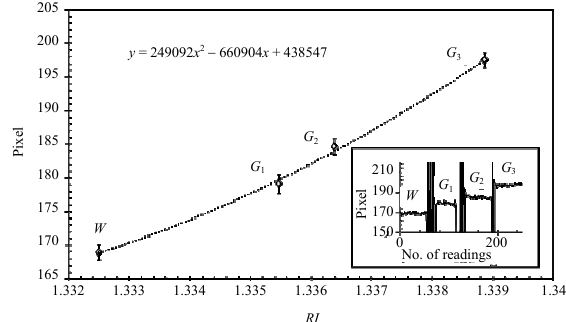
Fig. 12 Plot of dip position with respect to RI. Inset, system response for solutions: water ( W = 1.33250), and glycerol of different RIs ( G 1 = 1.33547, G 2 = 1.33639, and G 3 =